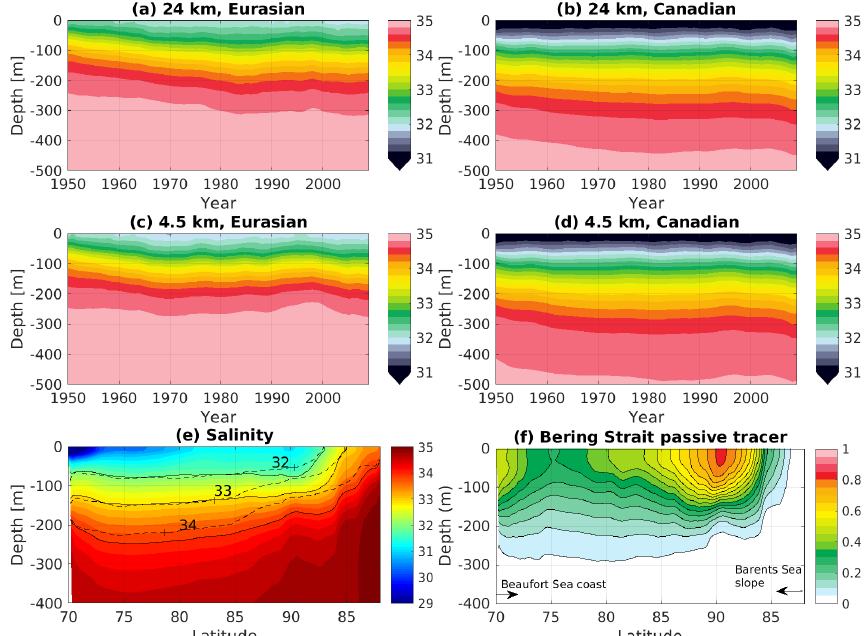
Figure 8. Hovmöller diagram of mean salinity for (a) the Eurasian Basin and (b) the Canadian Basin obtained in simulation LOW. Pan- els (c, d) are the same as (a, b) but for simulation HIGH. (e) Salinity at the transect along the 140 ◦ W/40 ◦ E longitude averaged over the 1980–1999 period in simulation HIGH, shown by the color patch and solid contours. The dashed contours indicate the salinity at the be- ginning of the model simulation. This comparison between the initial state and the mean state when salinity does not show a strong trend is intended to explain the salinity drift during spin-up. (f) The same as panel (e) but for the passive tracer released in the Bering Strait. The location of the transect is indicated by the magenta line in Fig. 1. The whole simulation period of 1950–2009 is shown in panels (a) – (d)